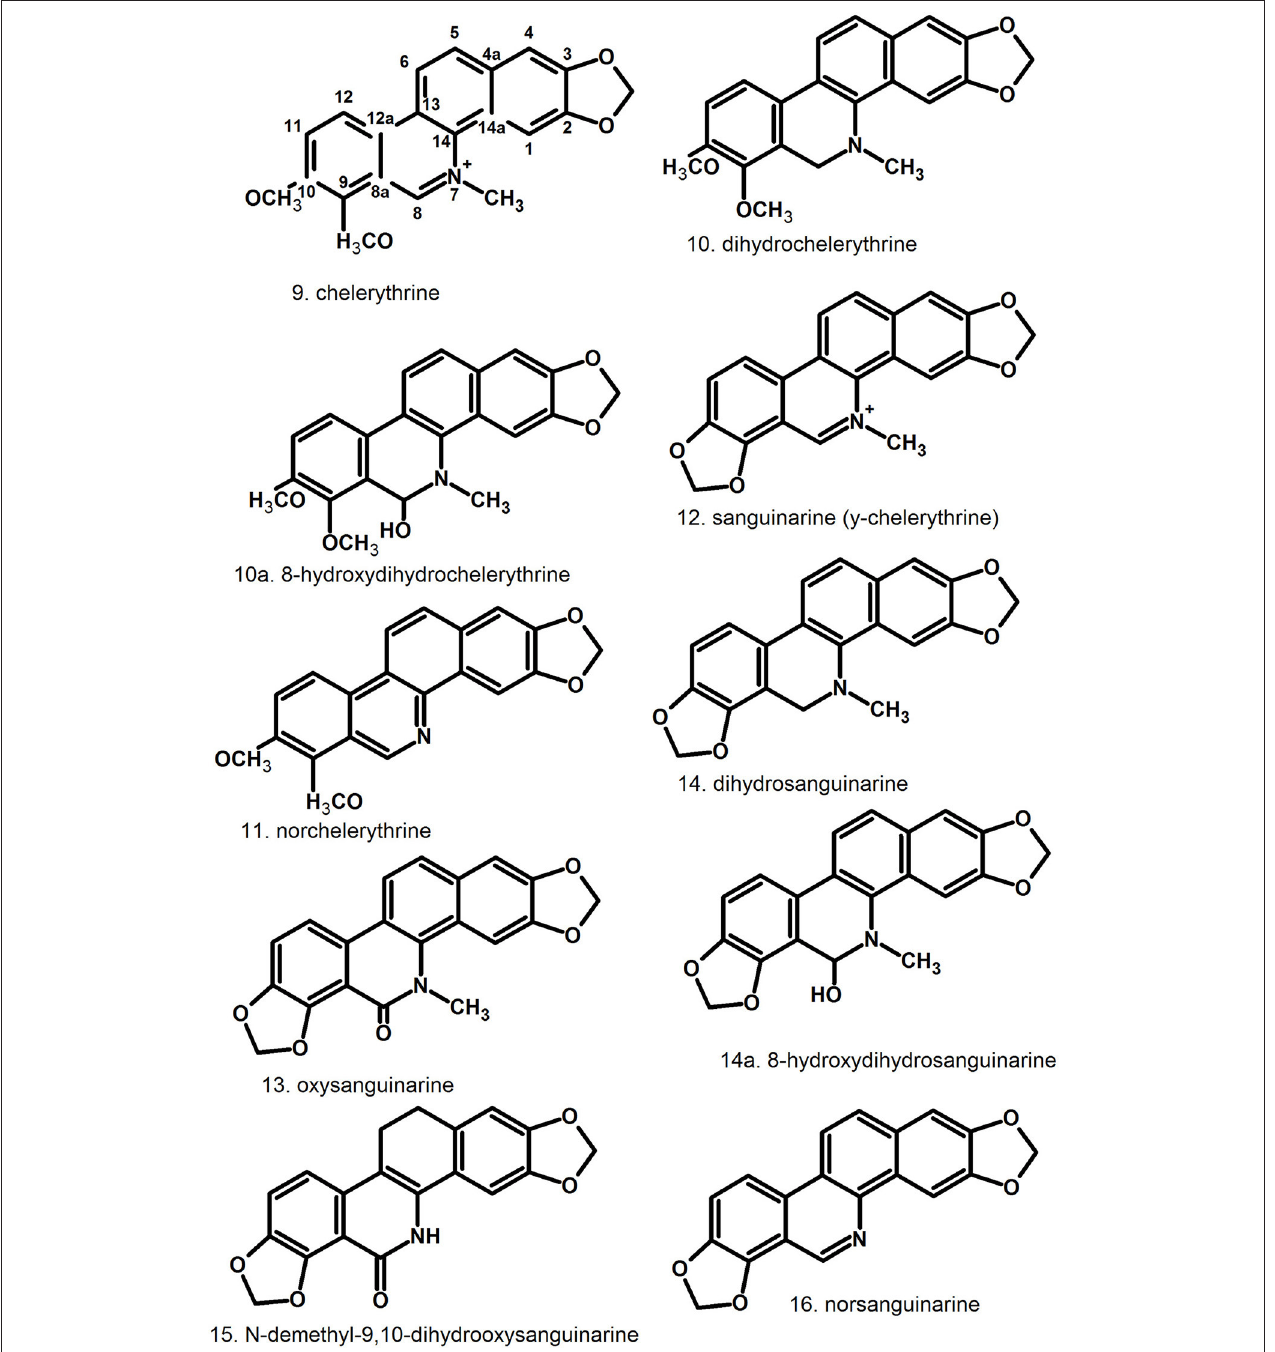
FIGURE 2 | Further structures of phenanthridine (3,4-benzoisoquinoline) alkaloids—chelerythrine [9] and sanguinarine [12] derivatives.